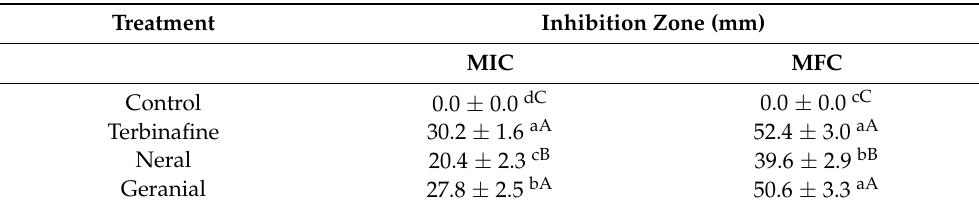
Table 1. Inhibition zone diameter of Trichophyton rubrum ATCC28188 treated with specific agents.